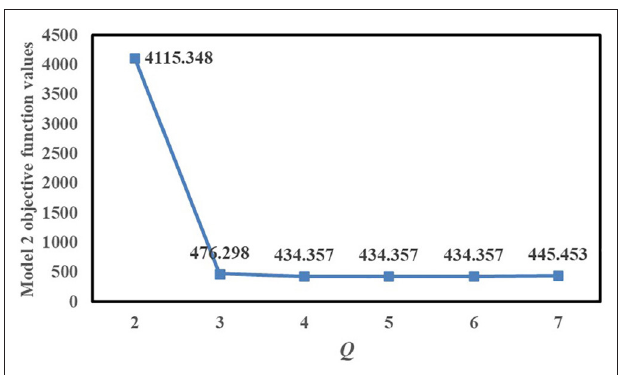
FIGURE 5 | Variation of Model 2 objective function value with Q .